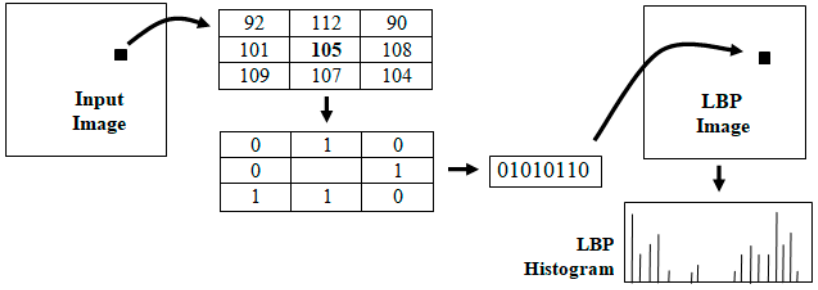
Figure 9. The intermediate steps in the computation of the LBP histogram of an image.